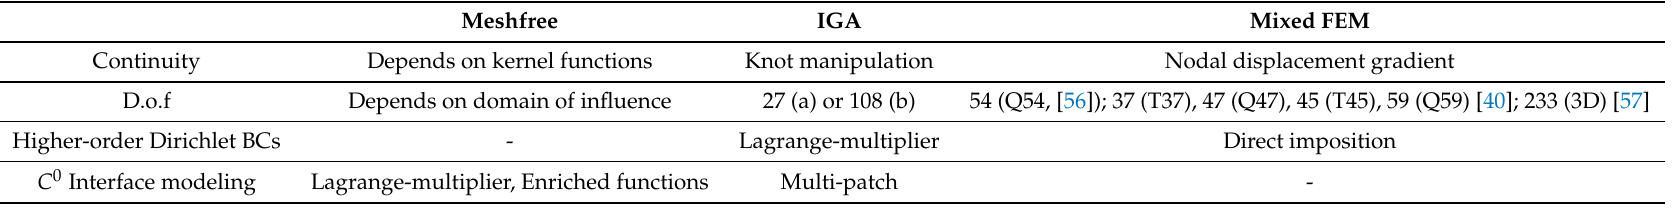
Table 3. Comparison of different numerical methods. ( a ) and ( b ) indicate quadratic elements in 2D and 3D,